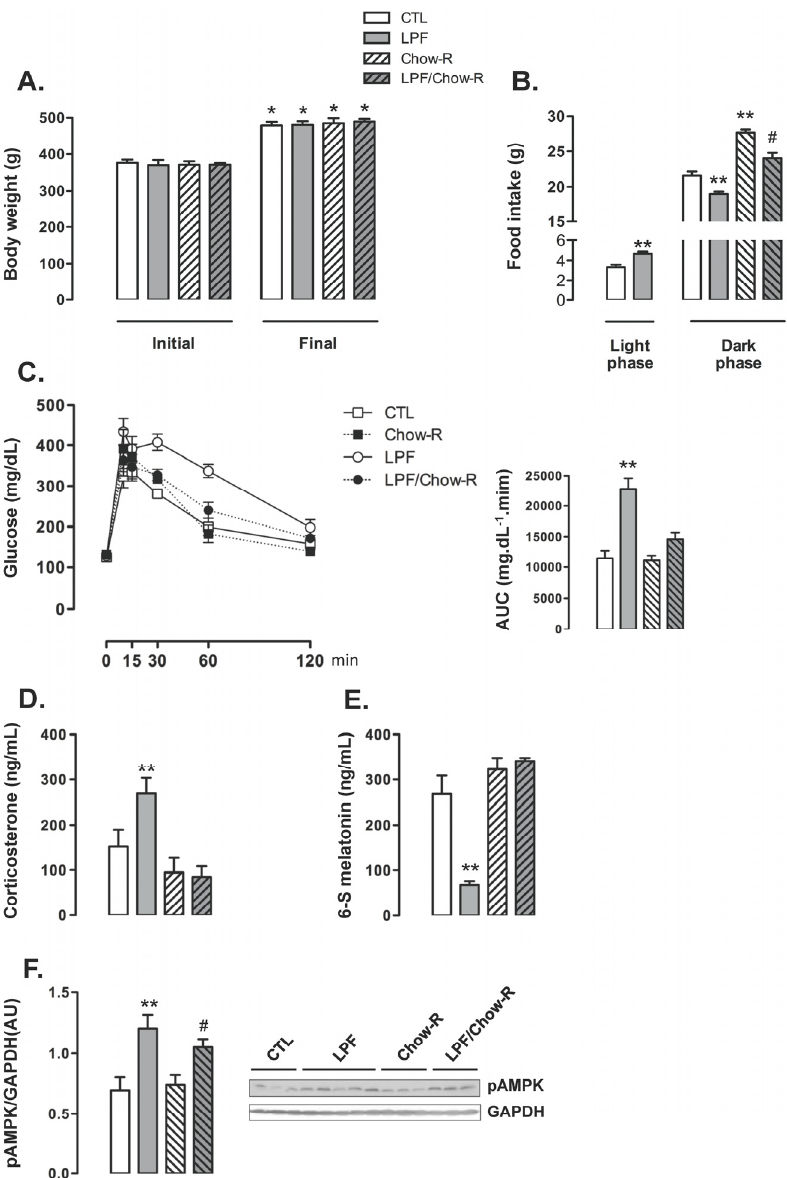
Figure 4. Dark ‐ restricted feeding in rats exposed to fructose during the light phase. Rats were assigned to the groups Control (CTL), Light Phase Fructose (LPF), Chow restriction to the dark phase (Chow ‐ R) and Light Phase Fructose with Chow restriction to the dark phase (LPF/Chow ‐ R). ( A ) Body weights were assessed before and after (eight week) treatments; ( B ) Food intake during the light and the dark phases were also assessed at the end of the treatments; After these measurements ( C ), the rats were subjected to glucose tolerance tests. Tests were performed two hours before “lights off” and area under the curve (AUC) was calculated. Euthanasia was performed two hours before “lights off” and the hypothalamus and plasma were collected; ( D ) Plasma samples were used for the determination of corticosterone levels; ( E ) Urine was collected overnight before euthanasia for determination of the 6 ‐ S ‐ Mel concentration; ( F ) Hypothalamus samples were used for Western blot detection of phosphorylated adenosine monophosphate ‐ activated protein kinase and normalization by Glyceraldehyde 3 ‐ phosphate dehydrogenase (GAPDH). The results are presented as the means ± standard error of the mean. * p < 0.05 vs. same group before treatment; ** p < 0.05 vs. CTL at the same phase of the light/dark cycle; # p < 0.05 vs. Chow ‐ R at the same phase of the light/dark cycle.